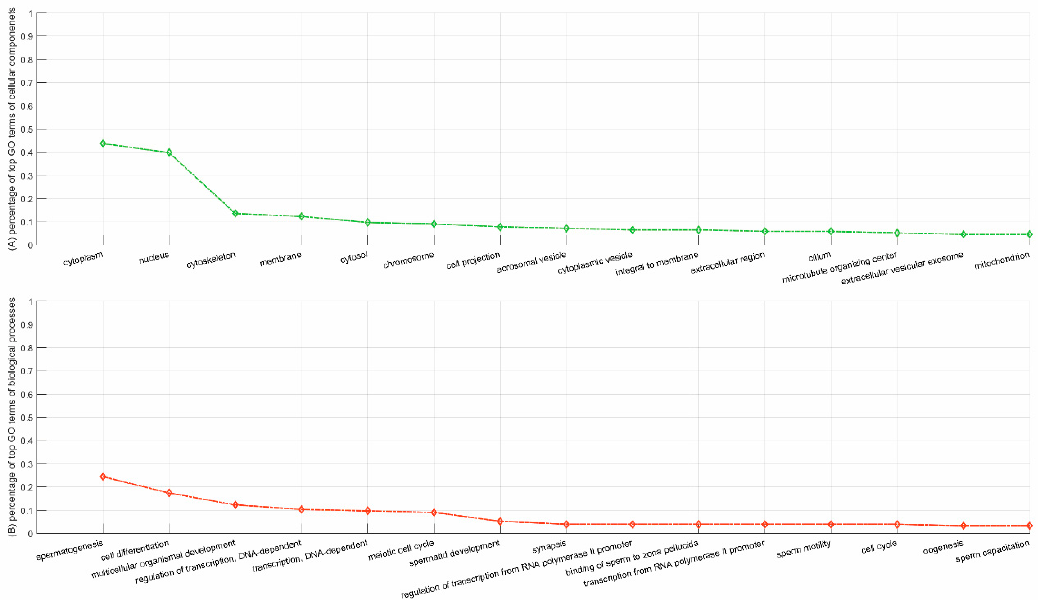
Figure 4. Percentages of top gene ontology (GO) terms of the genes/proteins that are validated to interact with the protein YBX2. The protein–protein interactions (PPIs) are extracted via the evidence of co-expression in STRING. ( A ) illustrates the percentage of top GO terms of cellular components; and ( B ) illustrates the percentage of top GO terms of biological processes.